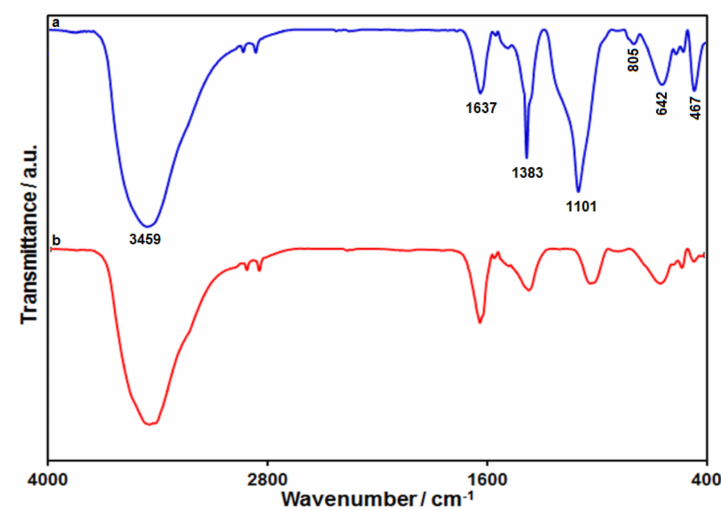
Figure 3. FT-IR spectra of ( a ) SiO 2 @Ni-Co LDH, and ( b ) Ni-Co